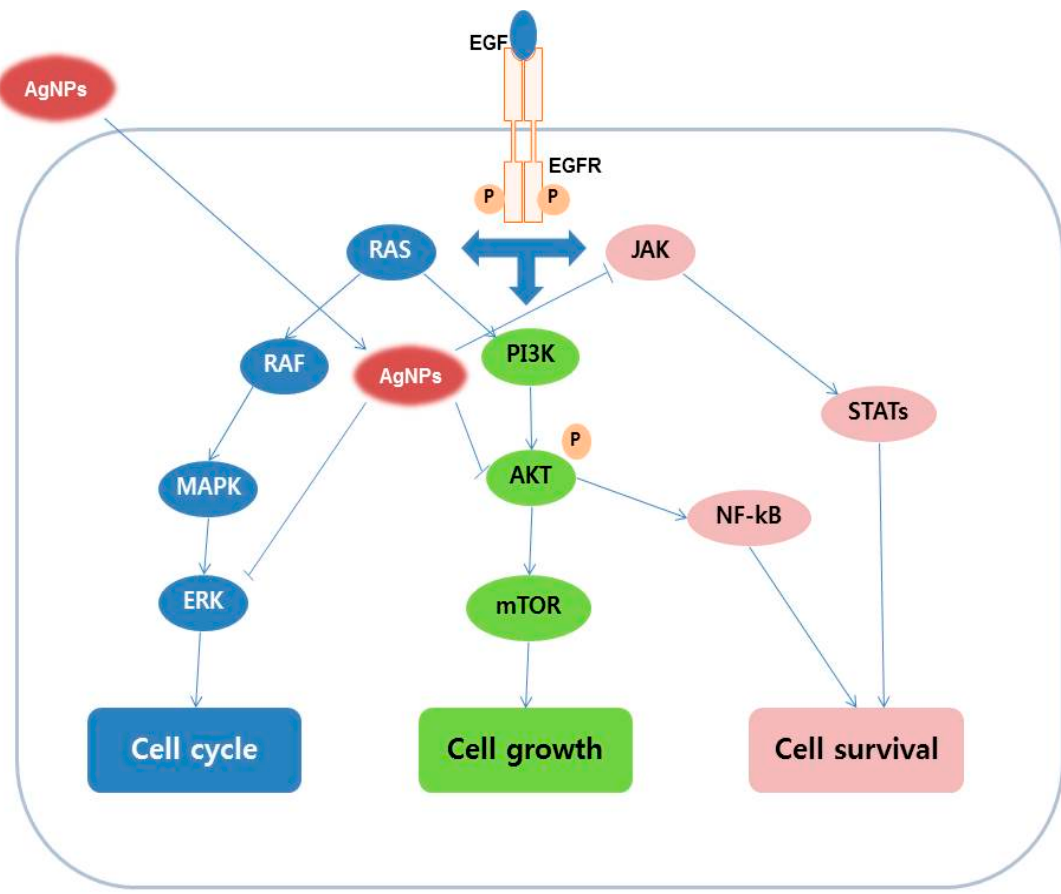
Figure 1. Proposed possible signaling pathways of inhibition effect of silver nanoparticles on EGF-induced cell growth, cell cycle, and cell survival in epithelial cancerous cells. AgNPs, silver nanoparticles; EGFR, epidermal growth factor receptor; RAS, Ras is a membrane-associated guanine nucleotide-binding protein; RAF, RAF kinases are a family of three serine/threonine-specific protein kinases; MAPK, mitogen-activated protein kinases; ERK, extracellular-signal-regulated kinases; PI3K, phosphatidylinositide 3-kinases; AKT, also known as protein kinase B (PKB); mTOR, mechanistic target of rapamycin; JAK, Janus kinase; STATs, signal transducers and activators of transcription; NF- κ B, nuclear factor-kappa B.